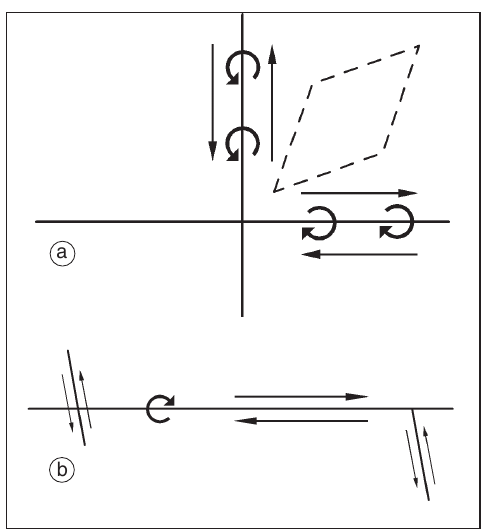
Fig. 1a,b. Fracture planes and rotation effects due to friction processes or dislocation motions: a) the symmetric case; b) the fracture along a main fault; the arrows indicate the shear stresses acting along the fracture